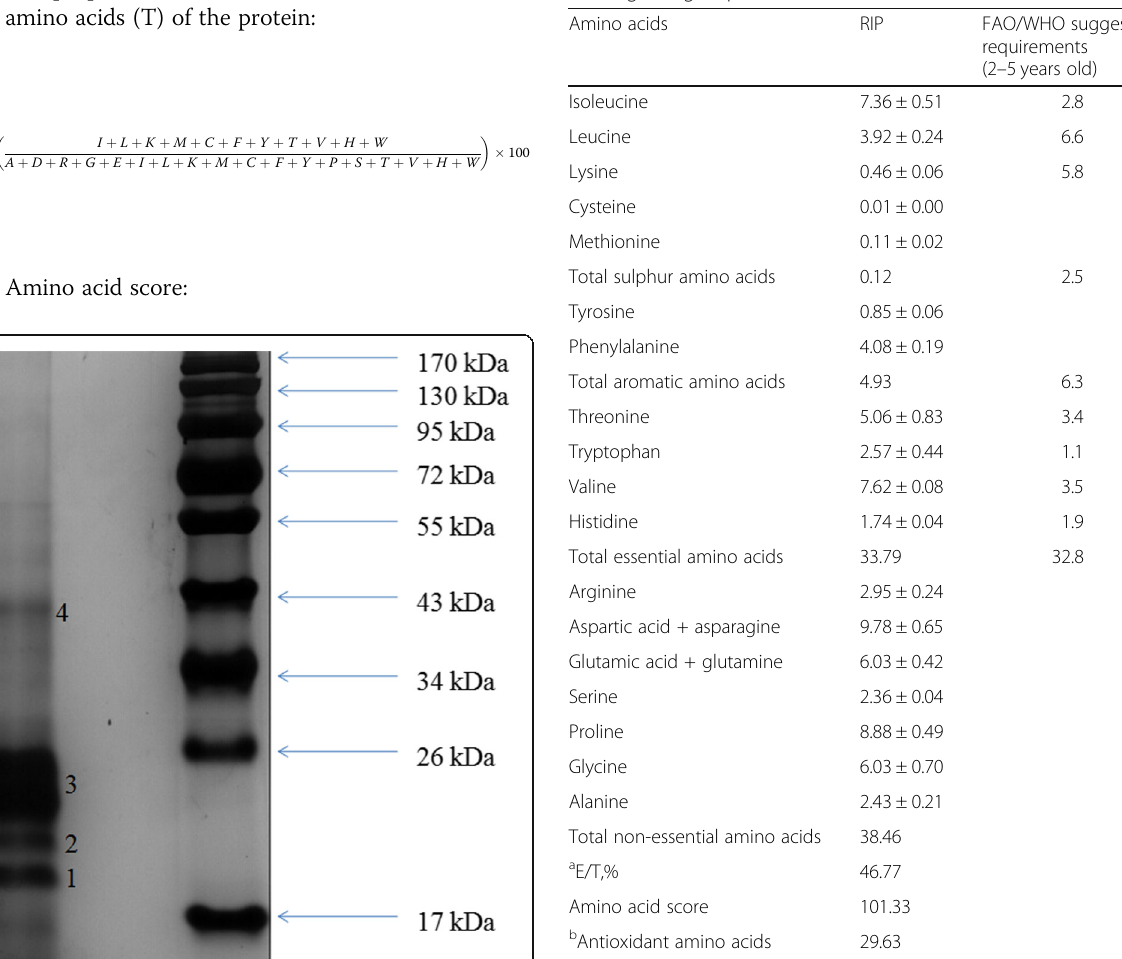
Table 1 Amino acid composition of RIP and the FAO/WHO suggested requirements (2 – 5 years old) for the essential amino acids (g/100 g of